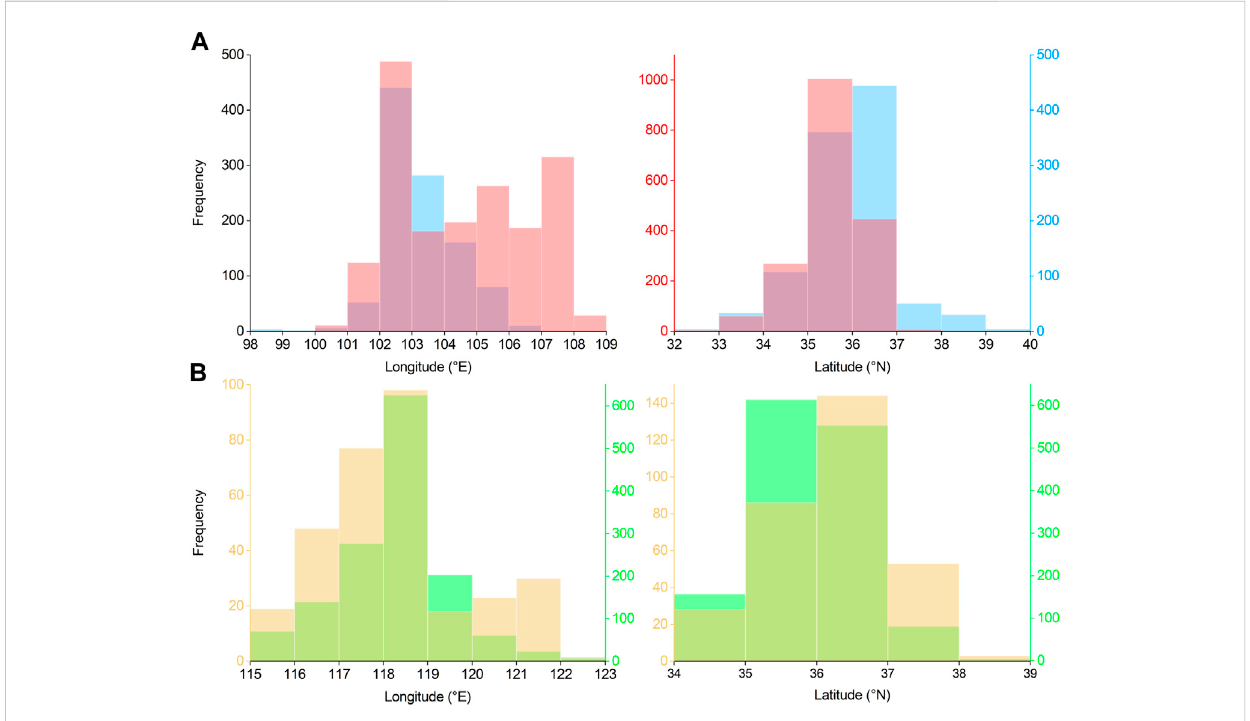
FIGURE 3 Frequency histograms showing the coordinates between the ended and started cultures. Note: (A) the Majiayao culture (blue) vs. the Qijia culture (red); (B) the Longshan culture (green) vs. the Yueshi culture (earthy yellow). The color of the y -axis follows the cultural type.